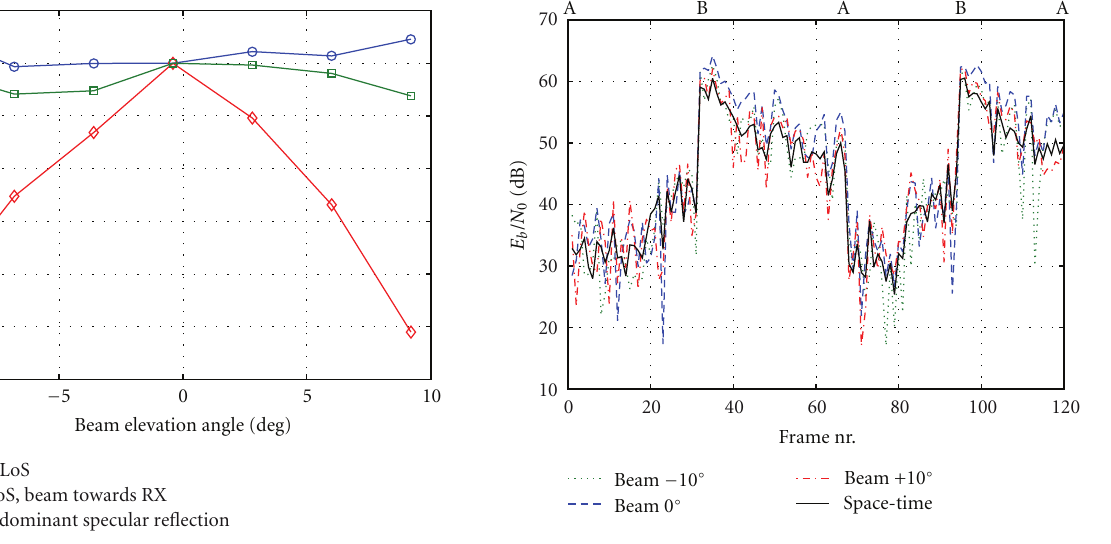
Figure 5: Average SNR as a function of the beam elevation angle, in the LoS environment, with the main beam directed towards and away from the receiver, as well as in the NLoS environment. The SNR is normalized to 0dB for the 0 ◦ elevation beam.